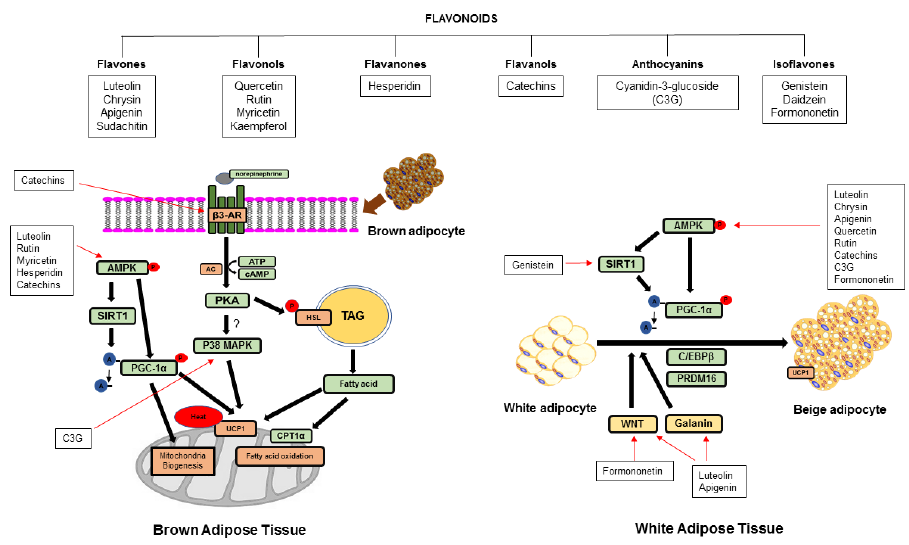
Figure 2. Suggested mechanistic pathway of different flavonoids in the activation of non‐shivering thermogenesis in BAT and WAT. AC; adenylyl cyclase, AMPK; AMP‐activated protein kinase, ATP; adenosine triphosphate, β -AR; beta-adrenergic receptor, cAMP; cyclic AMP, C/EBP β ; CCAAT/enhancer-binding protein beta CPT1 α ; carnitine palmitoyltransferase 1 alpha, HSL; hormone sensitive lipase, PGC1 α ; peroxisome proliferator-activated receptor gamma coactivator 1 alpha, PKA; protein kinase A, PRDM16; positive regulatory domain containing 16, p38 MAPK; p38 mitogen-activated protein kinase, SIRT1; silent mating type information regulation 2 homolog 1, TAG; triacylglycerol, UCP1; uncoupling protein 1, WNT; wingless type.